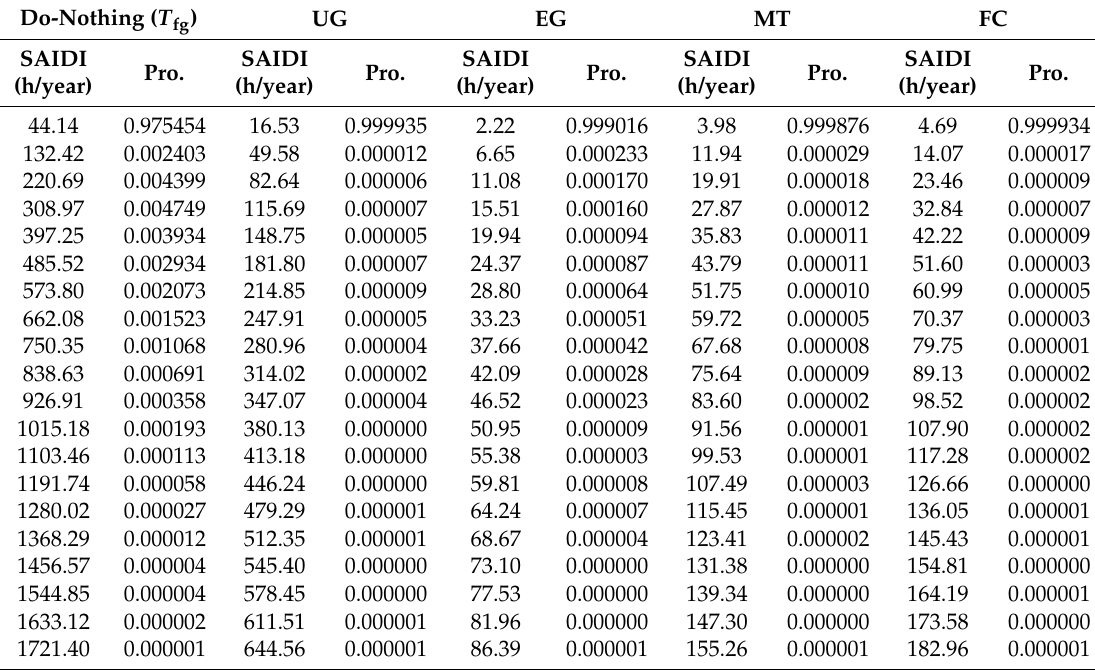
Table 3. Reliability data of hardening options (Town